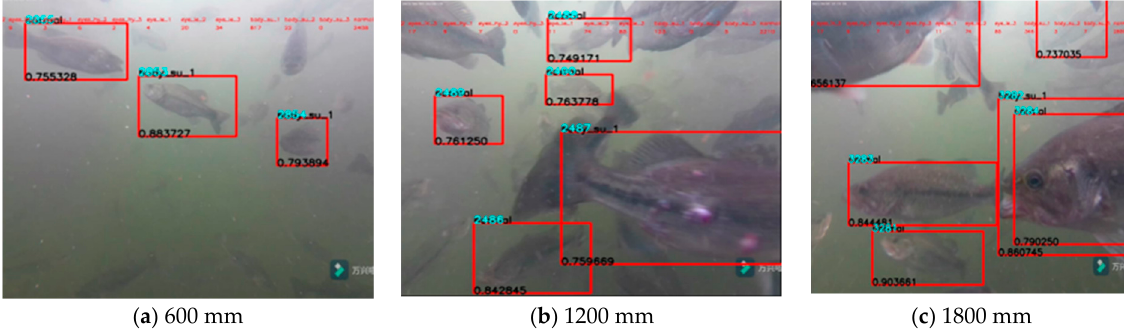
Figure 11. Monitoring effect at different water depth.